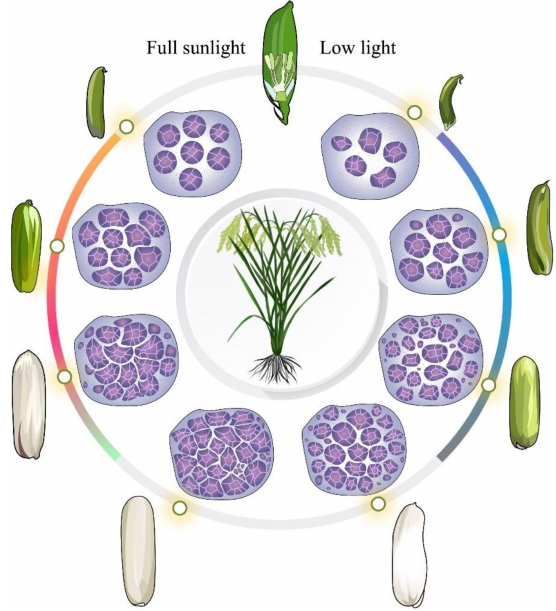
Figure 6. Pattern map depicting rice grain